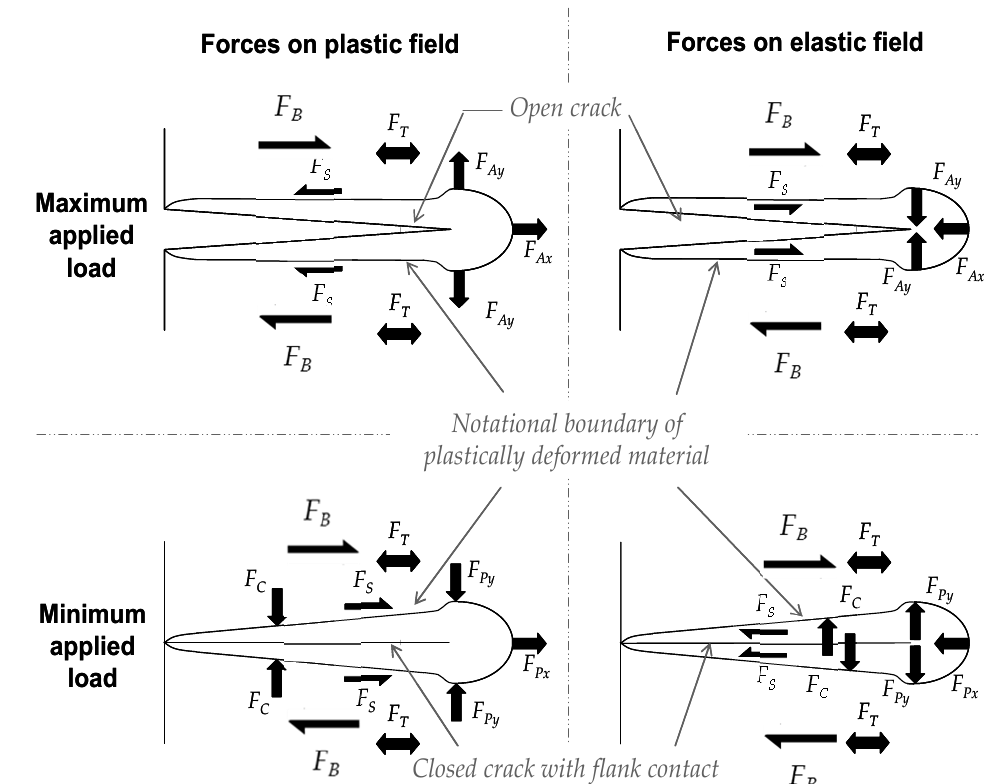
Figure 1: Schematic idealisations of forces acting at the interface of the plastic enclave and the surrounding elastic material, where F A is the Mode I applied force generating the crack tip stress field usually characterized by K I , F B is the additional applied force induced by Mode II loading, F T represents the force due to the T-stress shown in this example as positive, F S is the interfacial shear force between the elastic and plastic zones, F C and F P together create the shielding effect. F P is the force generated by the constraint of compatibility on the plastically deformed material and F C is the contact force between the flanks of the crack generated by the interference of the plastic zones along the flanks